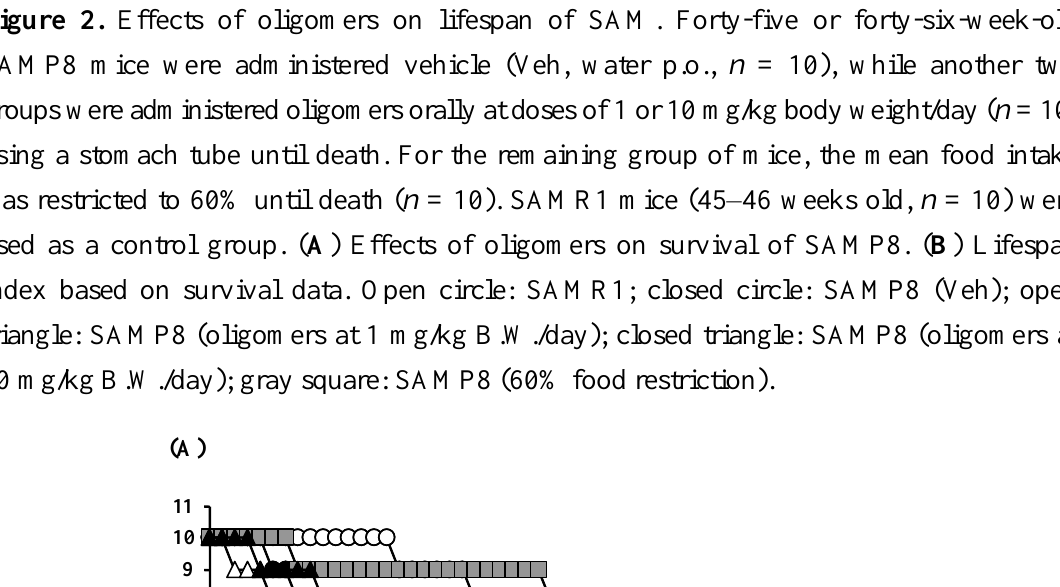
Group Lifespan index SAMR1 2,207 SAMP8 Veh (water) 1,065 60% Food restriction (water) 2,105 Oligomers (1 mg/kg B.W./day) 1,590 Oligomers (10 mg/kg